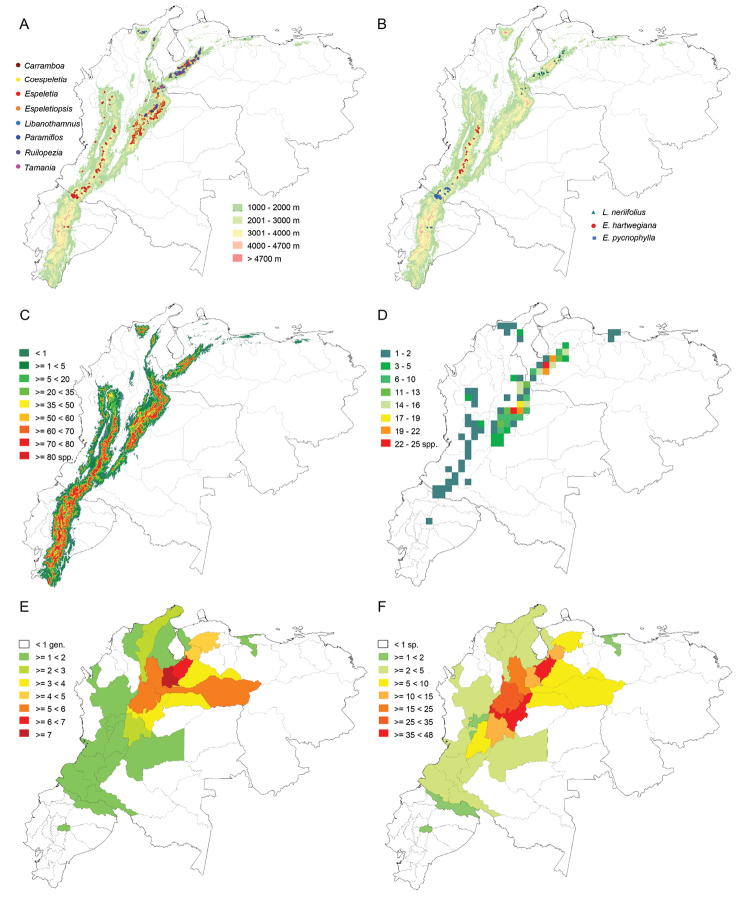
Geographic distribution and species richness of the subtribe Nomen nudum. A geographic distribution of the genera (colored dots); background color denotes mountains over 1000 m of elevation B distribution of three widespread species C species richness throughout the elevation, with classes every 200 m D species richness by area (squares: 0.4° × 0.4°); E richness of genera by state F species richness by state.